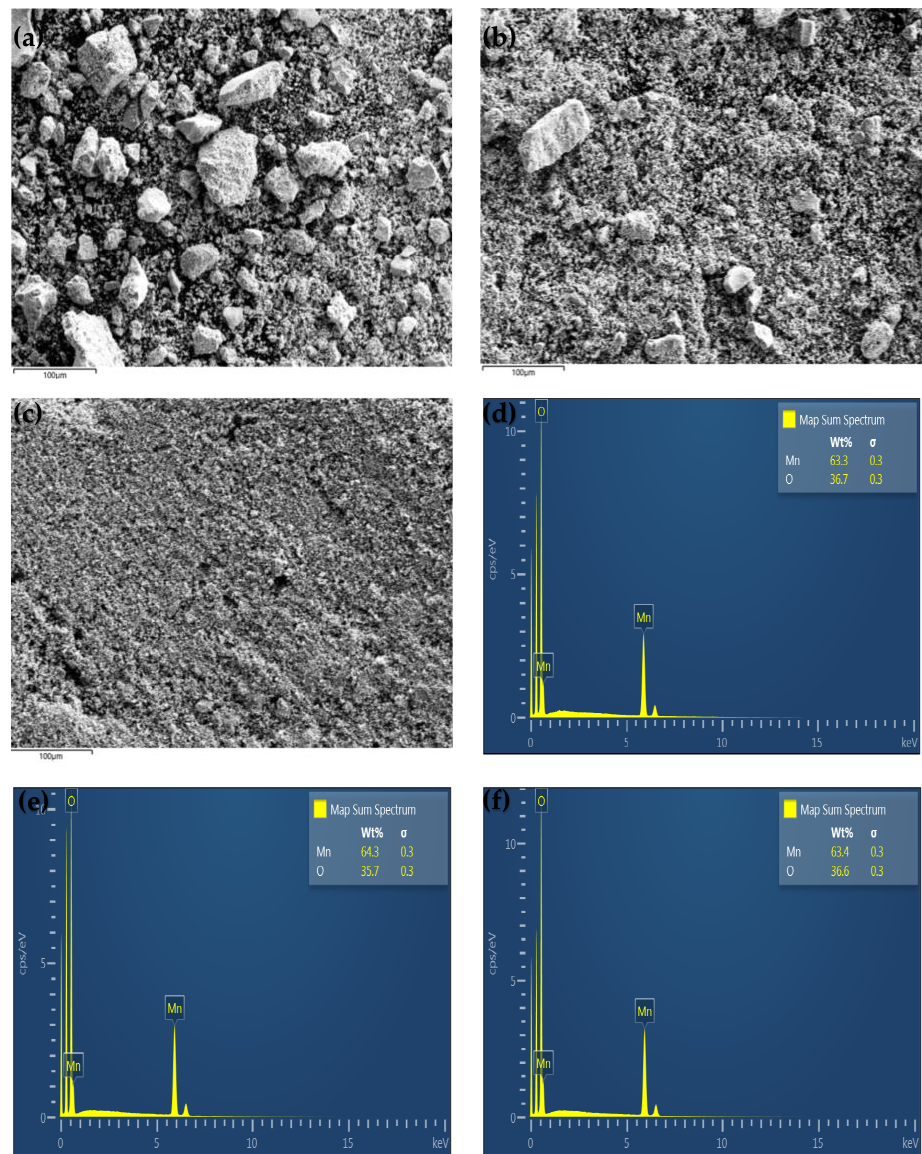
Figure 2. EDS electron images of ( a ) LMO-W, ( b ) LMO-E, and ( c ) LMO-G. EDS spectra of ( d ) LMO-W, ( e ) LMO-E, and ( f ) LMO-G samples.